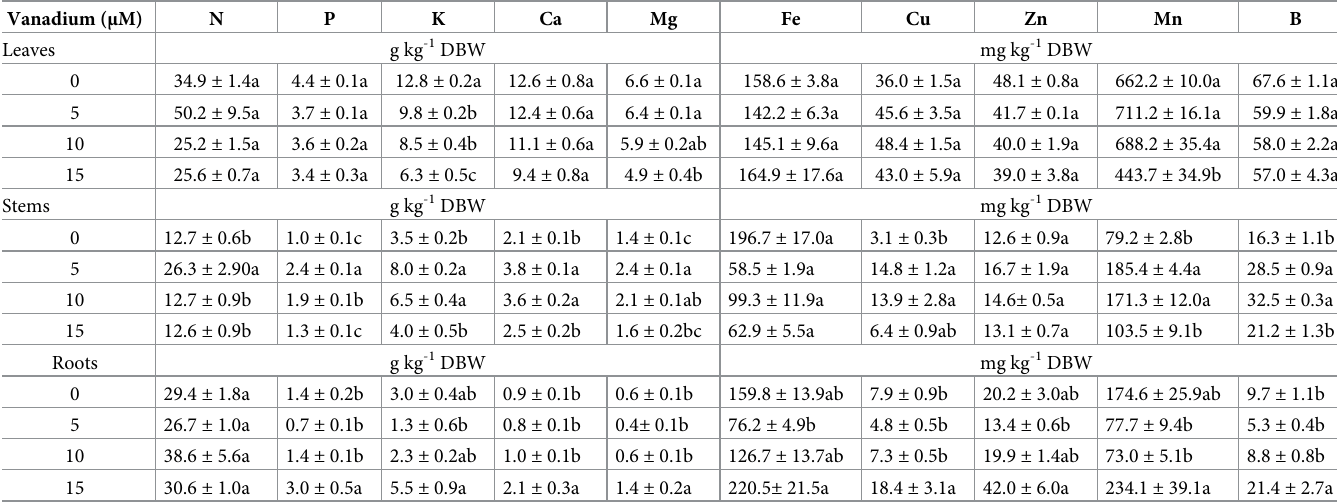
Table 3. Concentrations of mineral nutrient in leaves, stems and roots of pepper plants exposed to different concentrations of vanadium (V) for 28 days.